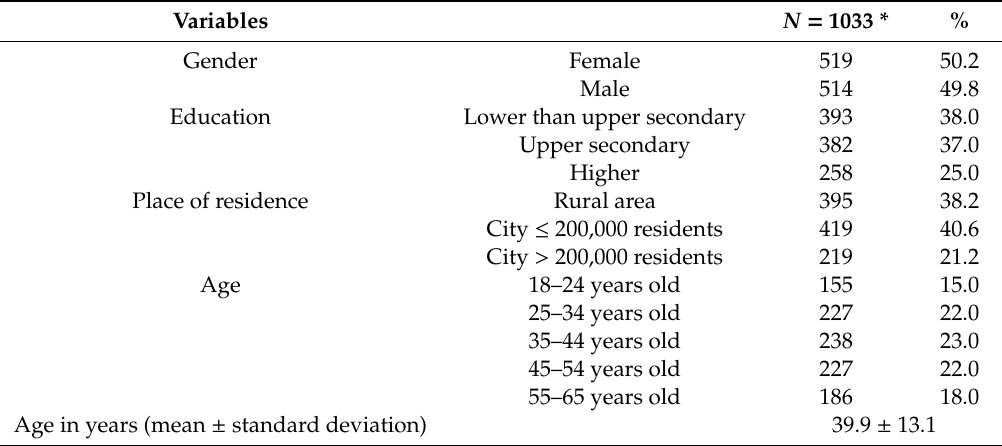
Table 2. Study sample